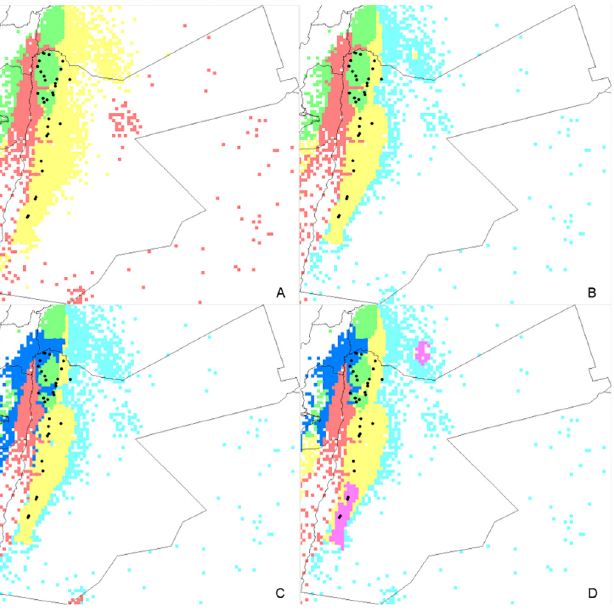
Fig 4. Habitat types in Jordan identified through k-means clustering. Black dots represent the Spontaneum collecting